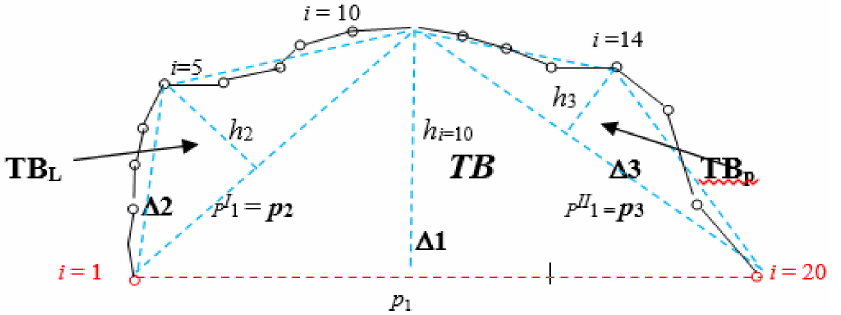
Figure 2. In the TB envelope of the creation of contraction triangles TK in accordance with the binary tree